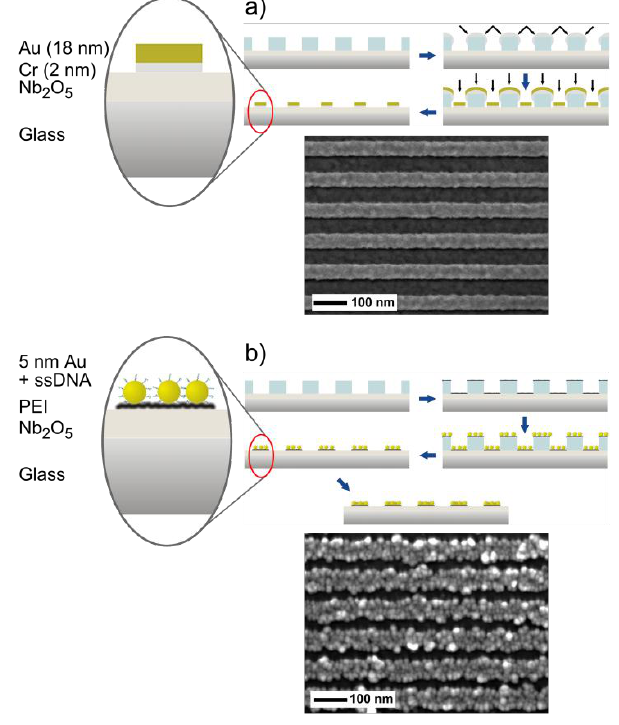
Figure 2. Continuous nanowires (a) are created through a process of shadow deposition where Cr is angularly evaporated as an intermediate layer and up to 50 nm of Au at normal incidence. Particle-based nanowires (b) are created in a process of Au nanoparticle adsorption to a PEI layer. In both processes the PMMA is removed with NMP (N-Methylpyrrolidone). The final step in image (b) illustrates the chemical enhancement of the gold nanoparticles, which is explained in more detail in the Appendix. The SEM Images show examples of the resulting nanowires from the corresponding fabrication